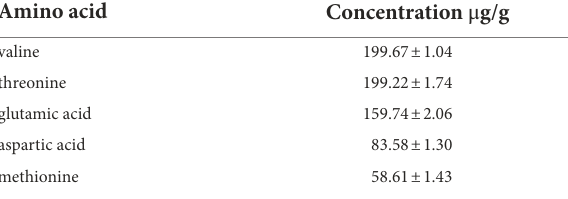
TABLE 5 Determination of the content of main amino acids in silkworm excrement. Amino